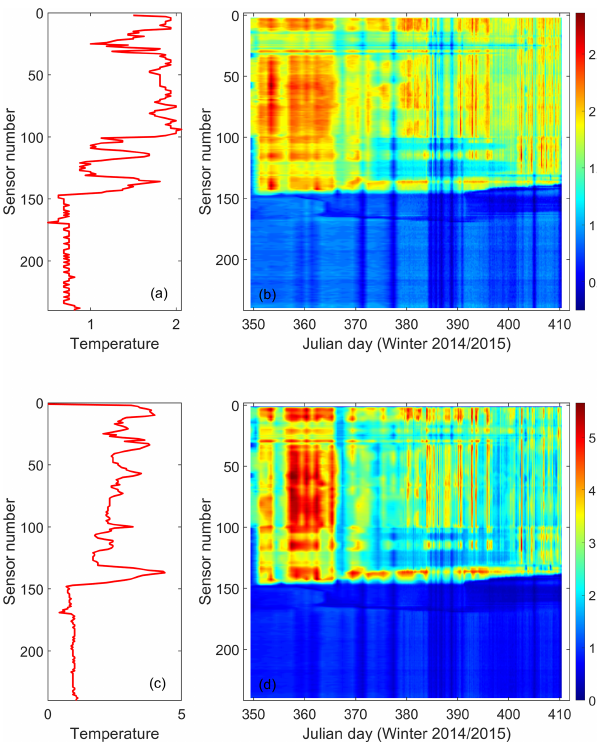
Figure 4. Illustrations of SIMBA-HT: (a) a snapshot (25 Jan- uary 2015, 18:00 UTC) of vertical profile of observed temperature increase after 60s. (b) SIMBA-HT (60s) field observed by 240 sen- sors. (c) Same as (a) but after heating for 90s, and (d) SIMBA-HT (90s) field observed by 240 sensors.